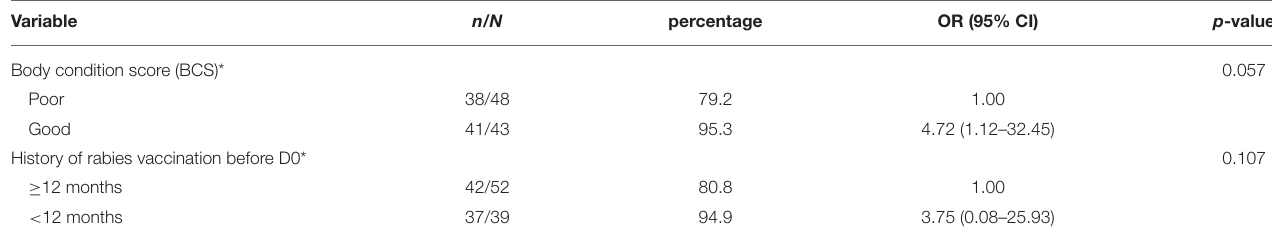
TABLE 5 | Determinants associated with developing of adequate level of binding antibodies 30 days after rabies vaccination in dogs on Flores Island, Indonesia, using multivariable logistic regression analysis.